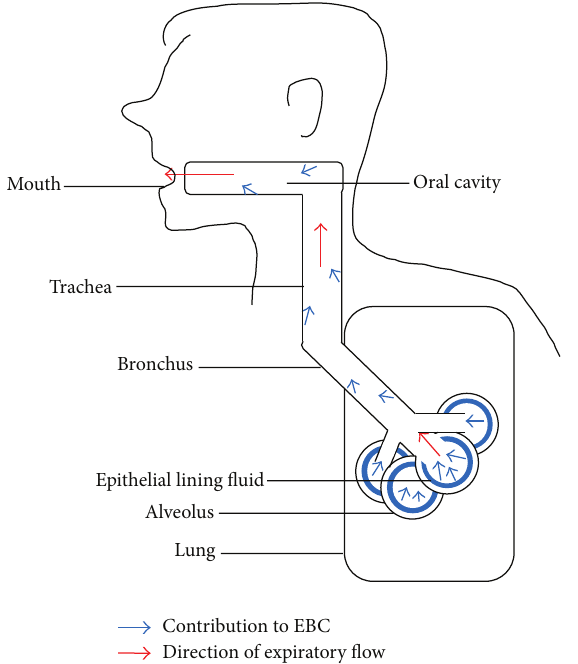
Figure 3: EBC consists of particles from ELF of alveoli, bronchi, and mouth, each with an unknown relative contribution.